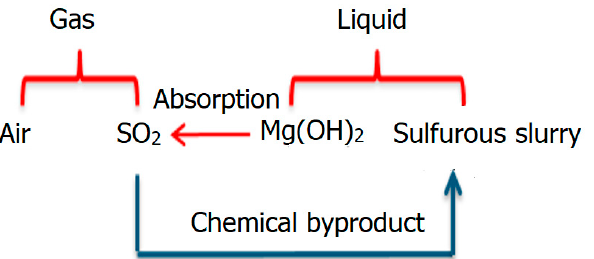
Figure 1. This schematic shows the components in gas and liquid phases during the desulfurization process. tion